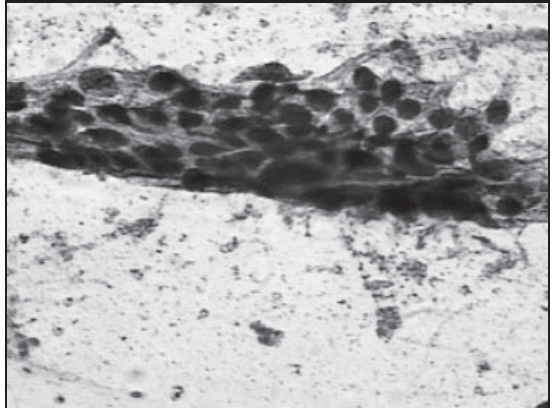
Figura 1 – Imagem obtida do esfregaço contendo células arranjadas em grupa- mentos sinciciais com discreta sobreposição e núcleos atípicos, hipercromáticos (Papanicolaou,